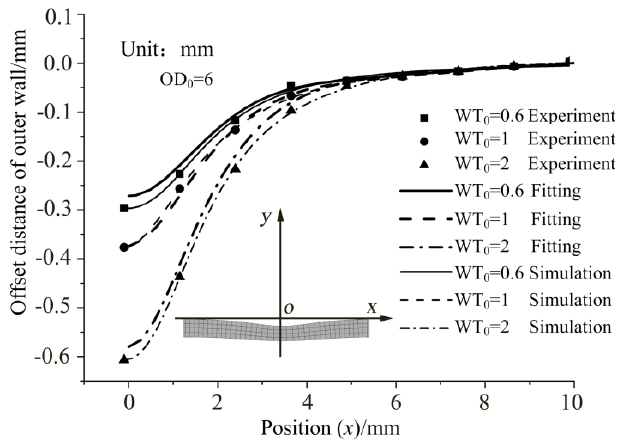
Figure 6. Outer wall profiles at fracture from tensile test and simulation and the logistic regression fitted curves in different wall thicknesses.